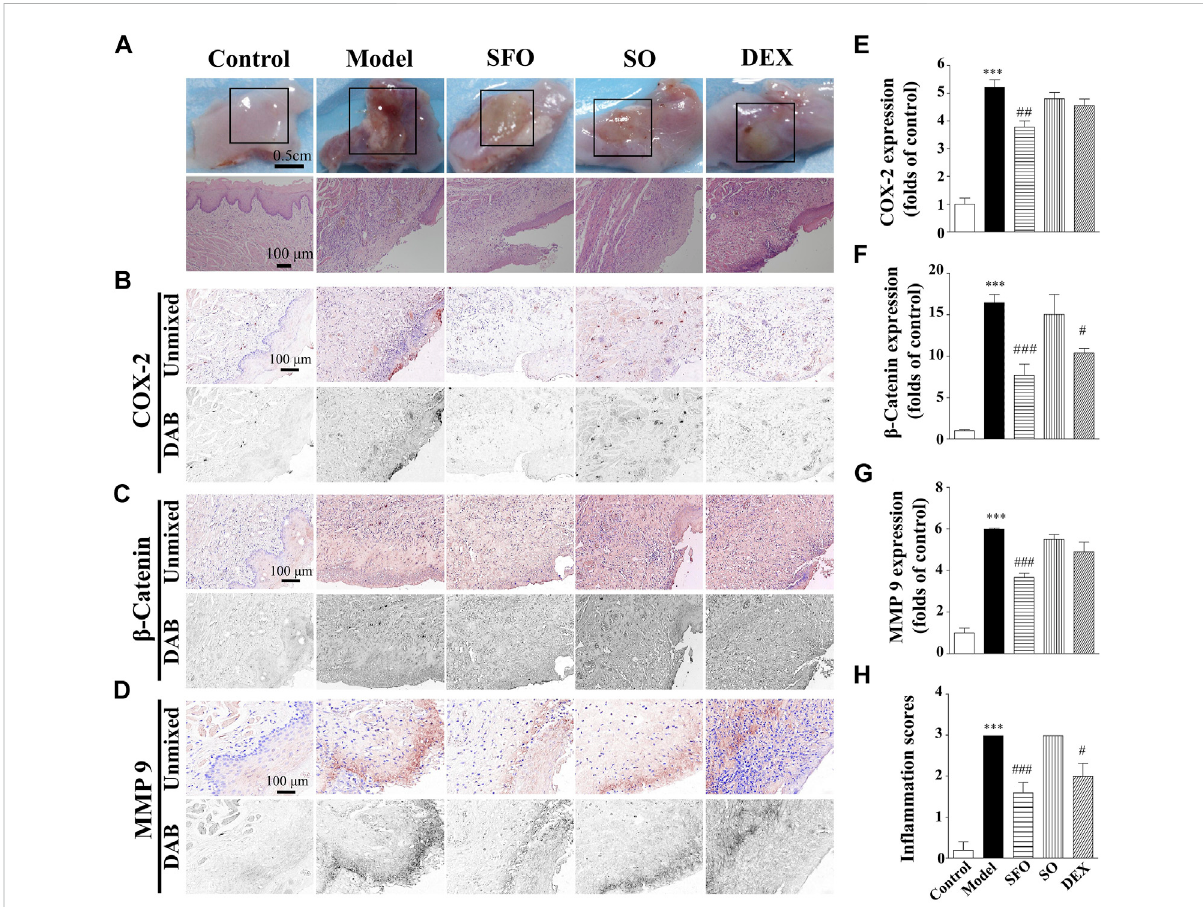
FIGURE 3 Decreased expression of COX-2, β -catenin and MMP-9 protein in the sodium hydroxide-burned wound tongue tissue of mice under ShengFu oil treatment. (A) General view of the tongue samples, and H&E staining of tongue sections in control, model, ShengFu oil (SFO), dexamethasone (DEX),andsesameoil(SO)groups.Representative (B – D) andsummary (E – G) ofhistochemistryanalysisofexpressionofCOX-2, β -cateninandMMP- 9, respectively. (H) The in fl ammation scores of the oral mucosa samples in the H&E-stained images. Scale bar, 100 µm. Compared with the control group, ppp , p < 0.001. Compared with the model group, #, p < 0.05, ##, p < 0.01, ###, p <